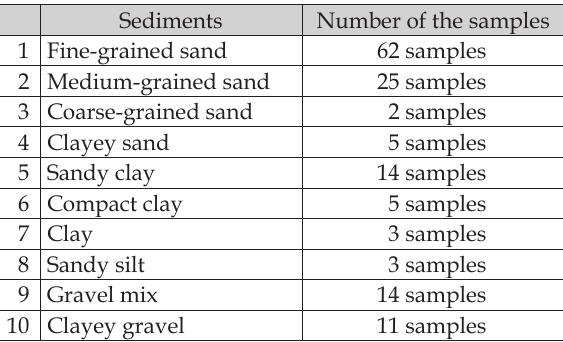
Table 1. Results of the sieve and aerometric analysis for 144 samples from boreholes Nos. 1 to